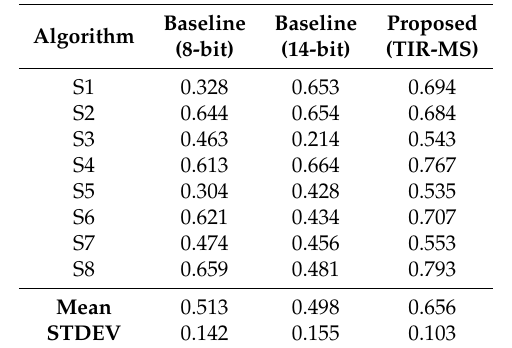
Table 5. Comparison of tracking accuracy: intersection over union (IOU).